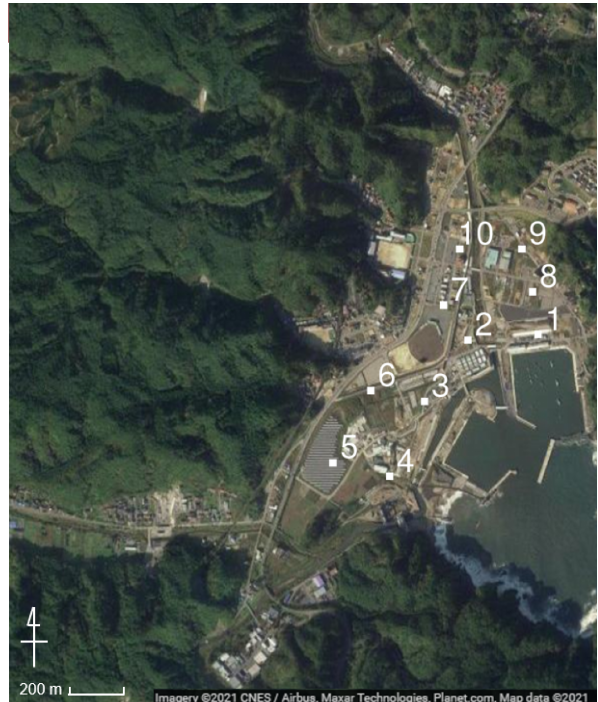
Figure 14. Evaluation points for comparing results obtained from numerical simulation and those of the surrogate models (© Google